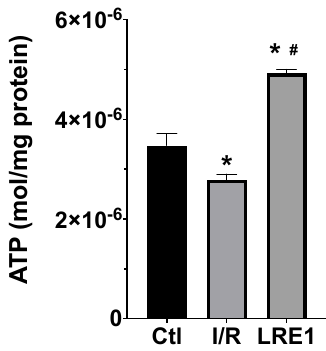
Figure 4. Liver mitochondria ATP content as evaluated with a bioluminescent assay. Data are means ± SEM of 4 independent experiments. * indicates a statistically significant difference vs. Ctl; # indicates a statistically significant difference vs. I/R.